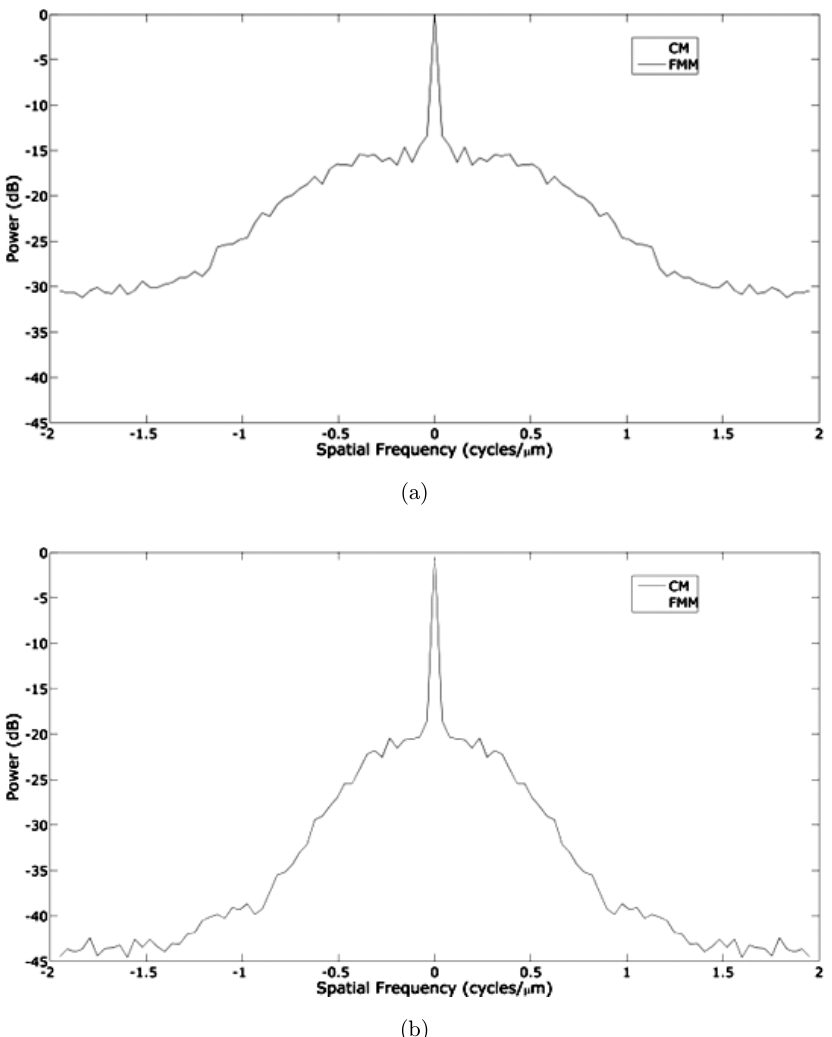
Fig. 14. Normalized spatial spectra in cycle/ (cid:1) m of the region of interests labeled by square boxes in Fig. 13(a) and 13(b) showing the spatial frequency components of (a) CM and (b) FMM